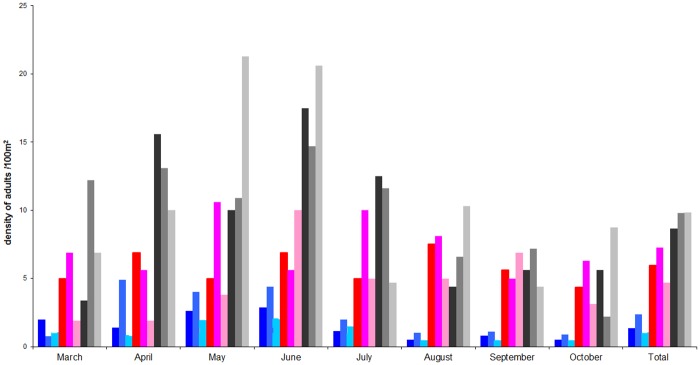
Density of I. ricinus adults in the five plots with chipmunks (α), one with little chipmunk (β) and two plots without chipmunk (γ) from the forest of Sénart in 2008, 2009 and 2011.α plots in 2008 (dark blue square), α plots in 2009 (cobalt blue square), α plots in 2011 (aquamarine square); β plots in 2008 (red square), β plots in 2009 (fuchsia square), β plots in 2011 (pink square); γ plots in 2008 (black square), γ plots in 2009 (grey square), γ plots in 2011 (light grey square).